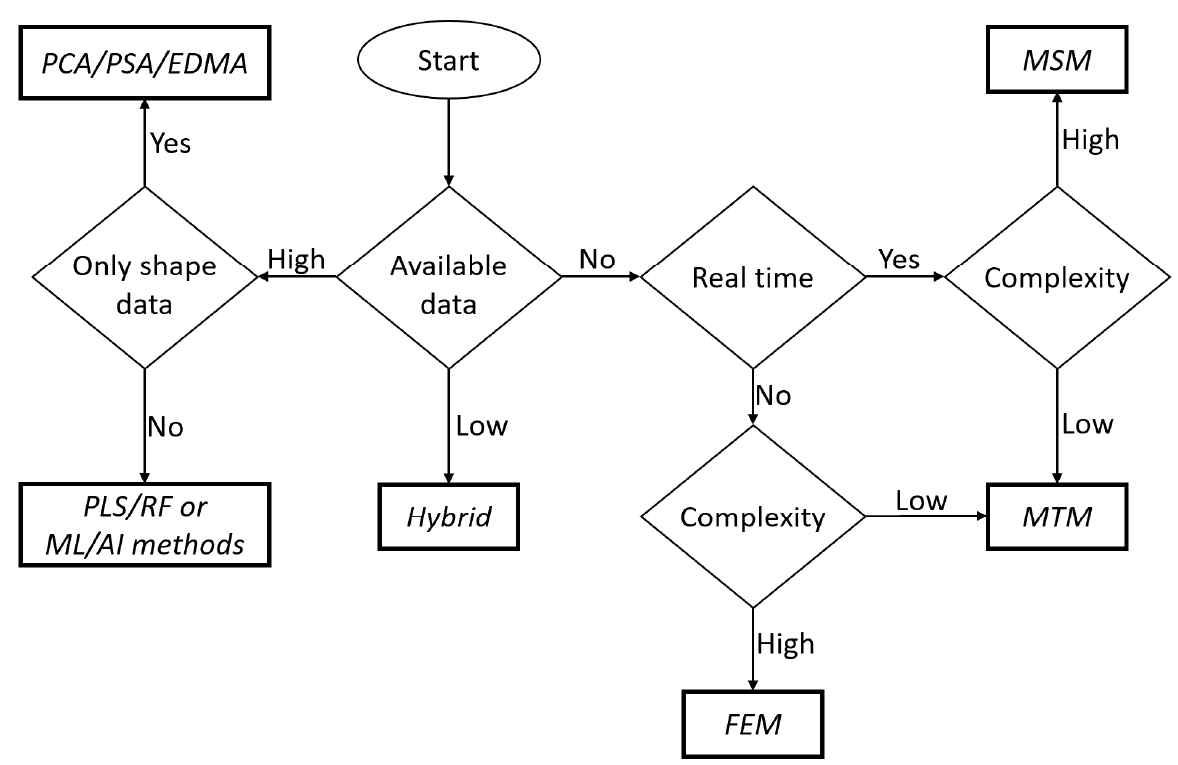
Figure 6. Algorithm for selection of prediction method.